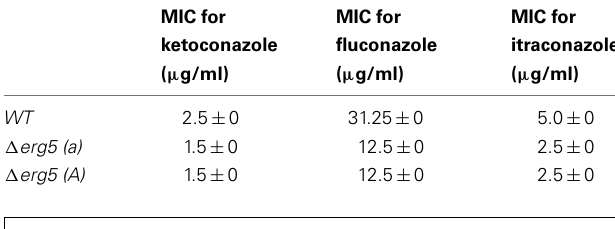
Table 4 | MIC of the erg5 mutant and wild type for azoles.